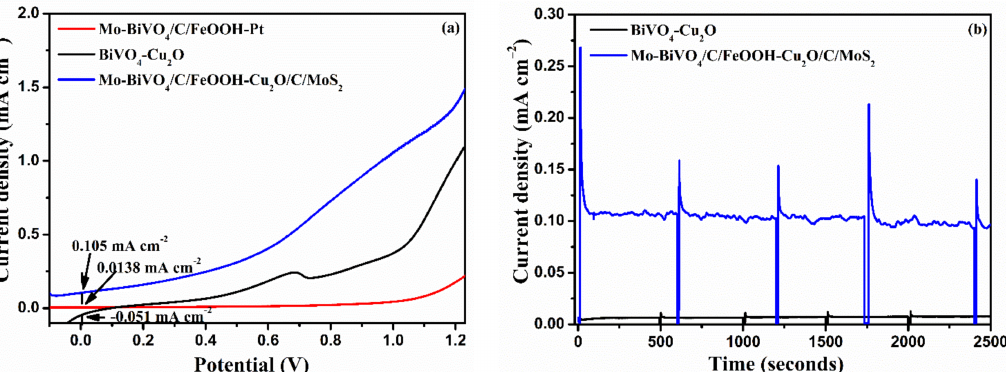
Figure 7. ( a ) 2-electrode LSV of Mo-BiVO 4 /C/FeOOH-Pt, BiVO 4 -Cu 2 O, and Mo-BiVO 4 /C/FeOOH- Cu 2 O/C/MoS 2 tandem cells, ( b ) Unassisted Chronoamperometry tests (J vs. t) of BiVO 4 -Cu 2 O and Mo-BiVO 4 /C/FeOOH-Cu 2 O/C/MoS 2 tandem PEC cells tested at zero bias in 0.1 M Na 2 SO 4 (pH 6) using an AM 1.5 G light source with a power intensity of 100 mW cm − 2